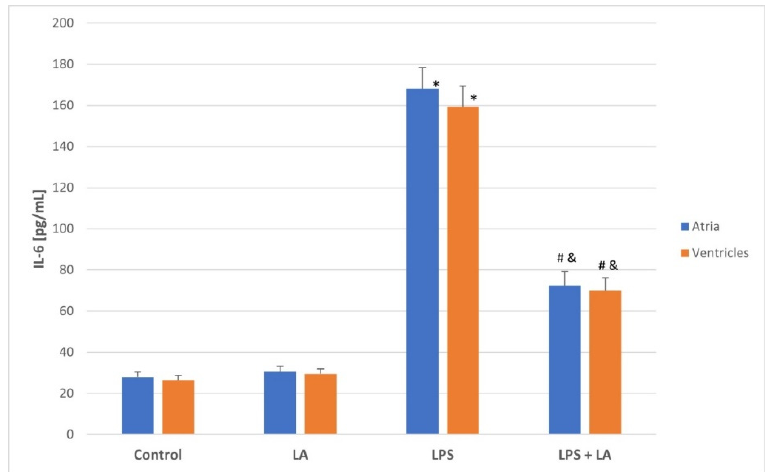
Figure 2. Effect of LA, LPS, and LPS + LA on Il-6 levels in ventricular and atrial homogenates. Results are shown as mean ± S.E.M. n = 8. * p < 0.05 vs. control, LA; # p < 0.01 vs. LPS; & p < 0.05 vs. control, LA. LA—alpha lipoic acid, LPS—lipopolysaccharide.